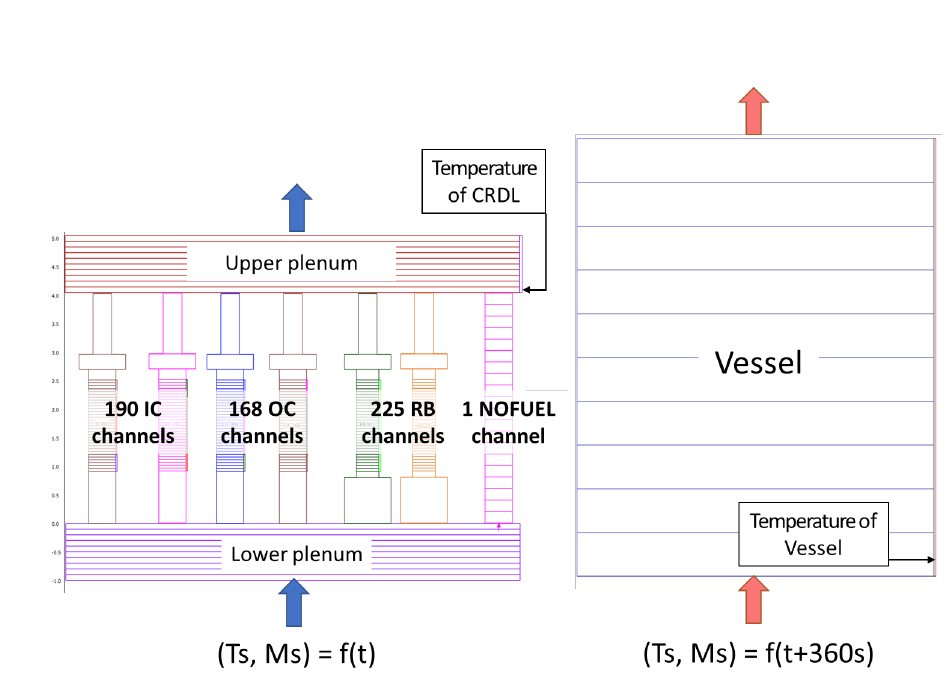
Figure 1: Thermal-hydraulic open core ATHLET model of